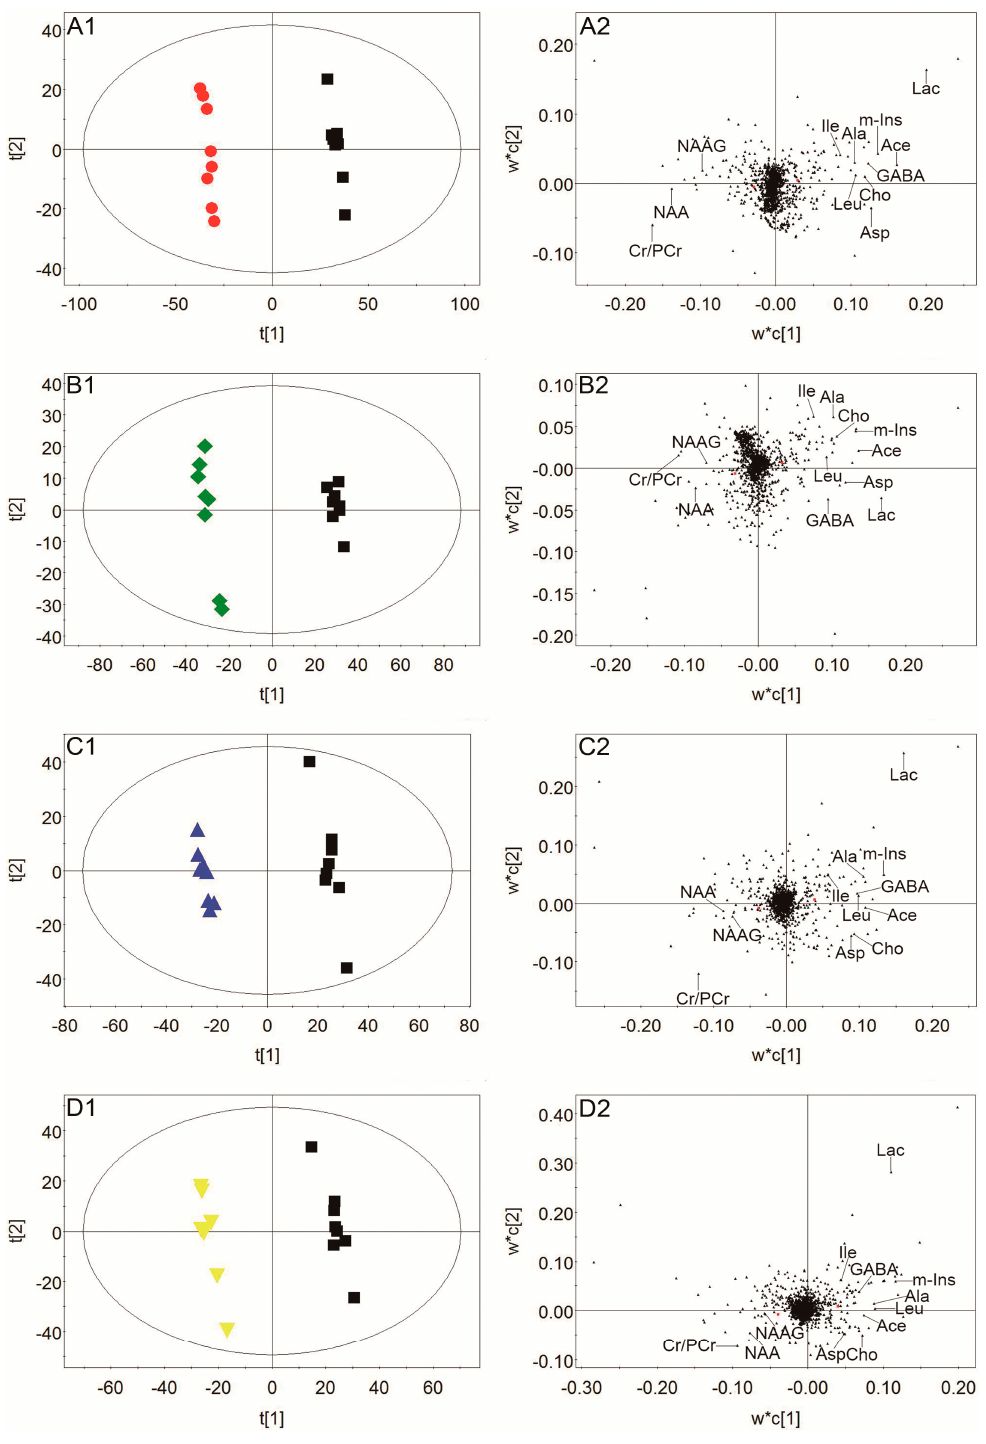
Figure 9. Score plots and loading plots of PLS-DA from brain tissue: Score plot ( A1 ) and loading plot ( A2 ) of the model and control groups, score plot ( B1 ) and loading plot ( B2 ) of the model and nimodipine groups, score plot ( C1 ) and loading plot ( C2 ) of the model and H-TCNDS groups, and score plot ( D1 ) and loading plot ( D2 ) of the model and L-TCNDS groups. (cid:8) Control group; (cid:4) Model group; Nimodipine group; H-TCNDS group; L-TCNDS group. H-TCNDS meaned high dosage of TCNDS (316.34 mg·kg − 1 ·d − 1 ), and L-TCNDS meaned low dosage of TCNDS (158.17 mg·kg − 1 ·d − 1 ).